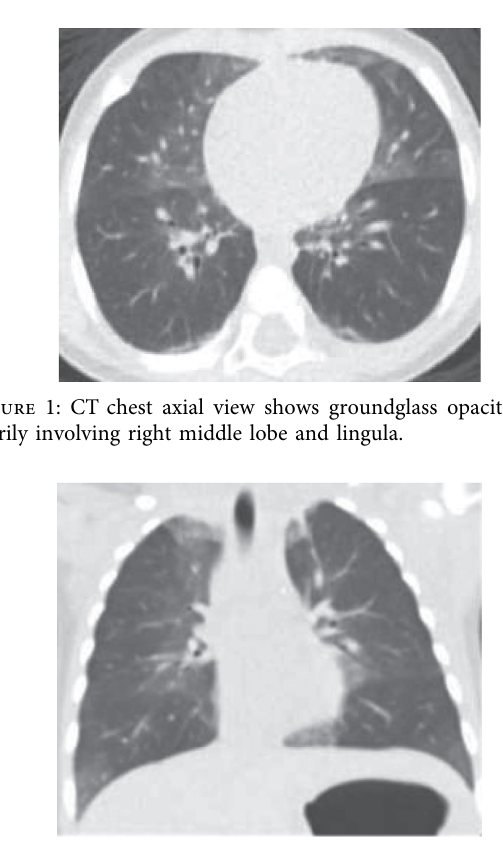
Figure 2: CTchest coronal view shows patchy central groundglass opacities and lower lobe